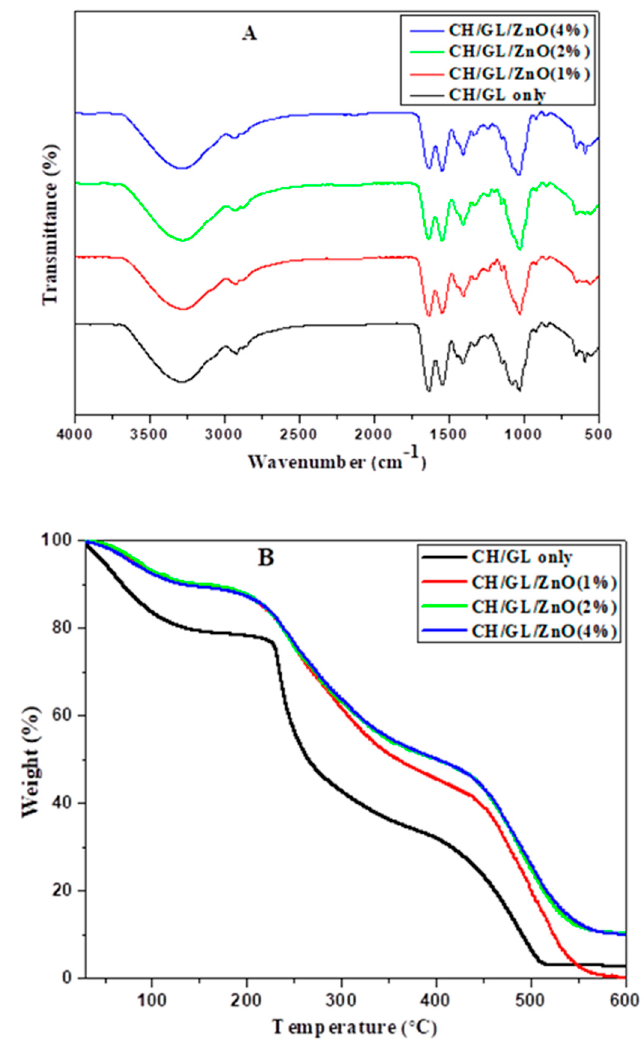
Figure 5. ( A ) Fourier-transform infrared spectroscopy (FTIR) spectra, and ( B ) thermogravimetric analyzer (TGA) thermograms of the developed hybrid films.